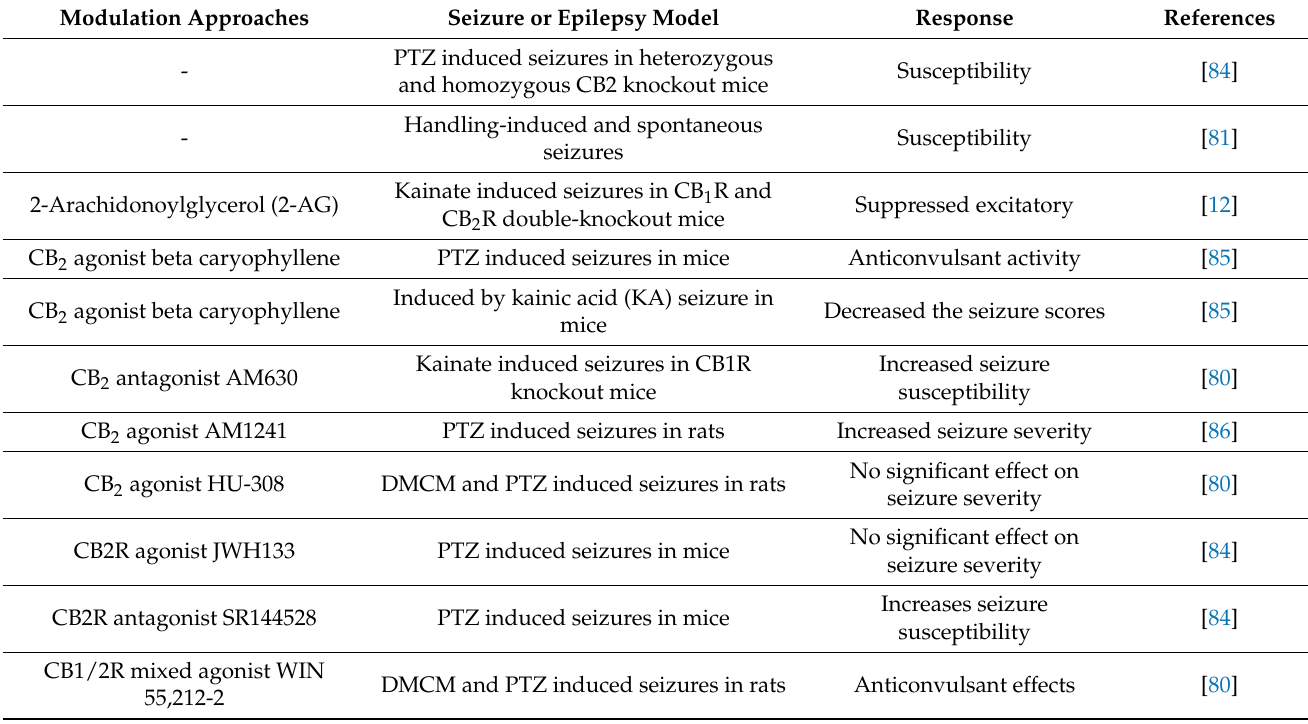
Table 1. Preclinical evidence for CB 2 R-mediated modulations in